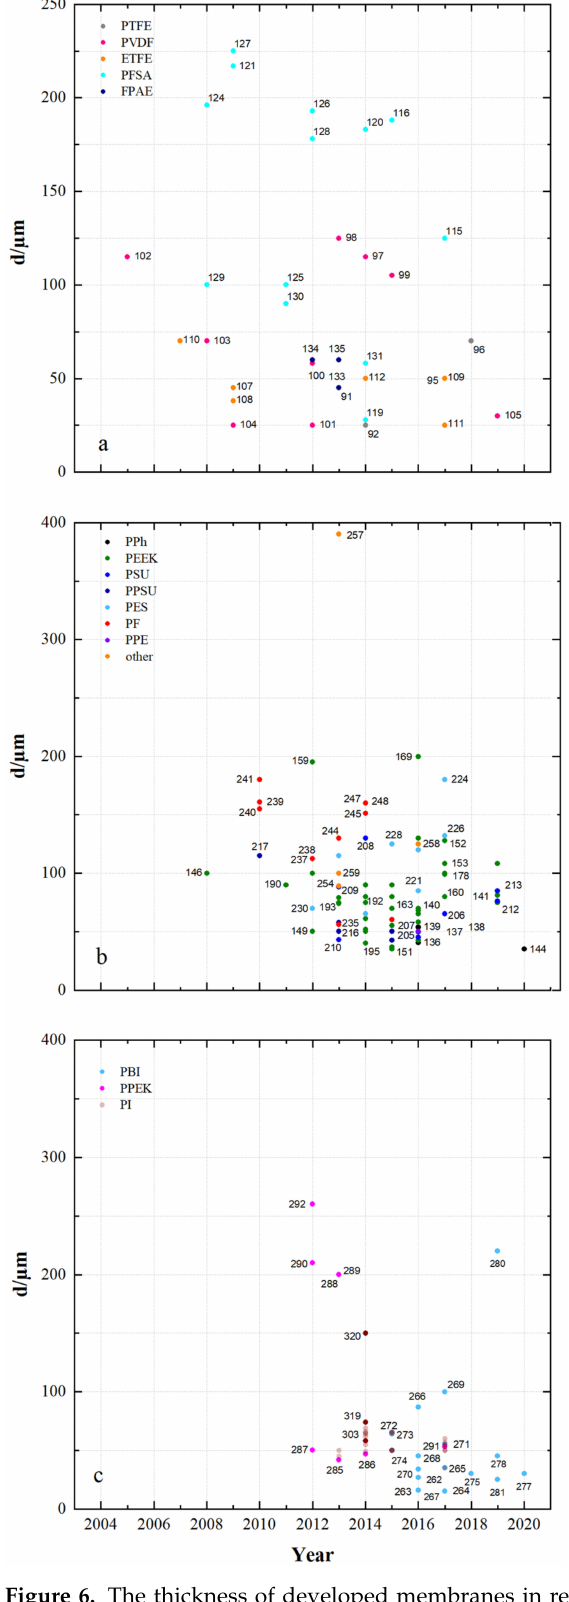
Figure 6. The thickness of developed membranes in recent years: ( a ) fluoro-carbons, ( b ) hydro- carbons and ( c ) N